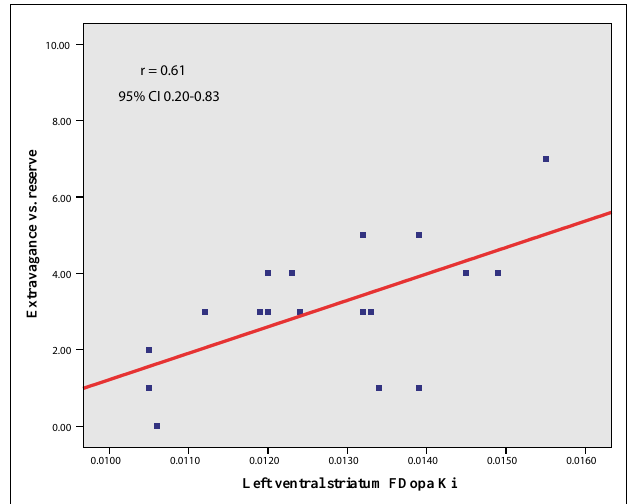
FIGURE 2 | Scatter plot (and line of best fit) showing the relation between trait disinhibition (NS3, Extravagance vs. reserve) and ventral striatal dopamine synthesis capacity (FDOPA K I ) in Parkinson’s disease.